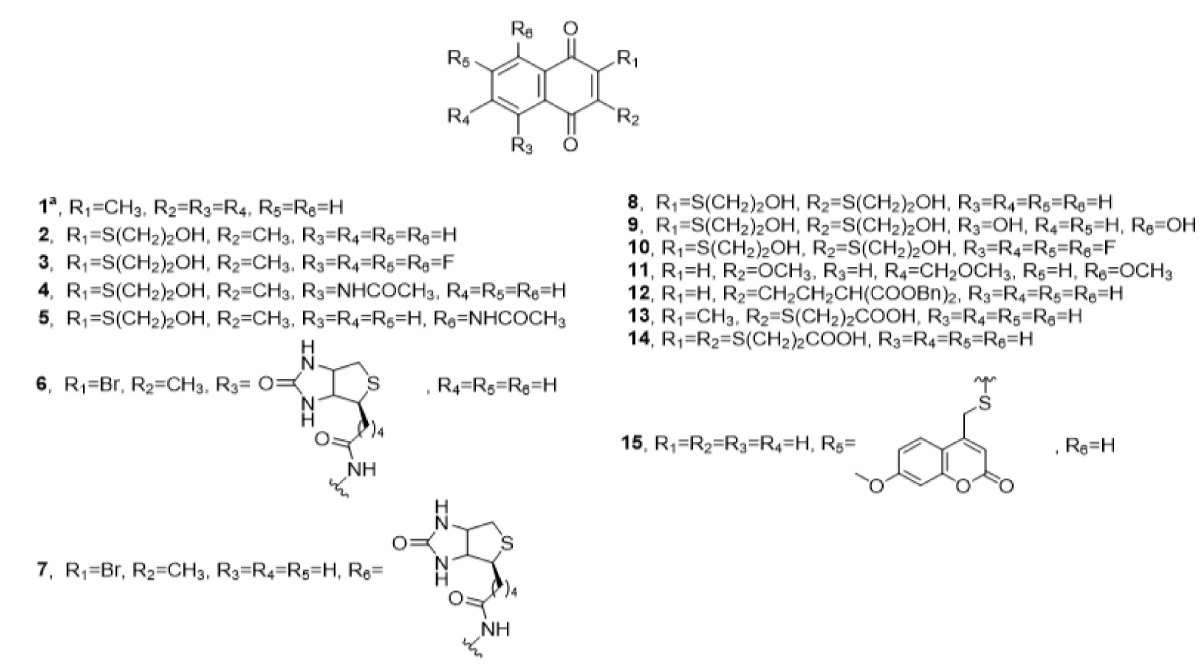
Figure 3. Cdc25 inhibitors based on quinoid structure. Table 1. Cdc25 inhibitors based on quinoid